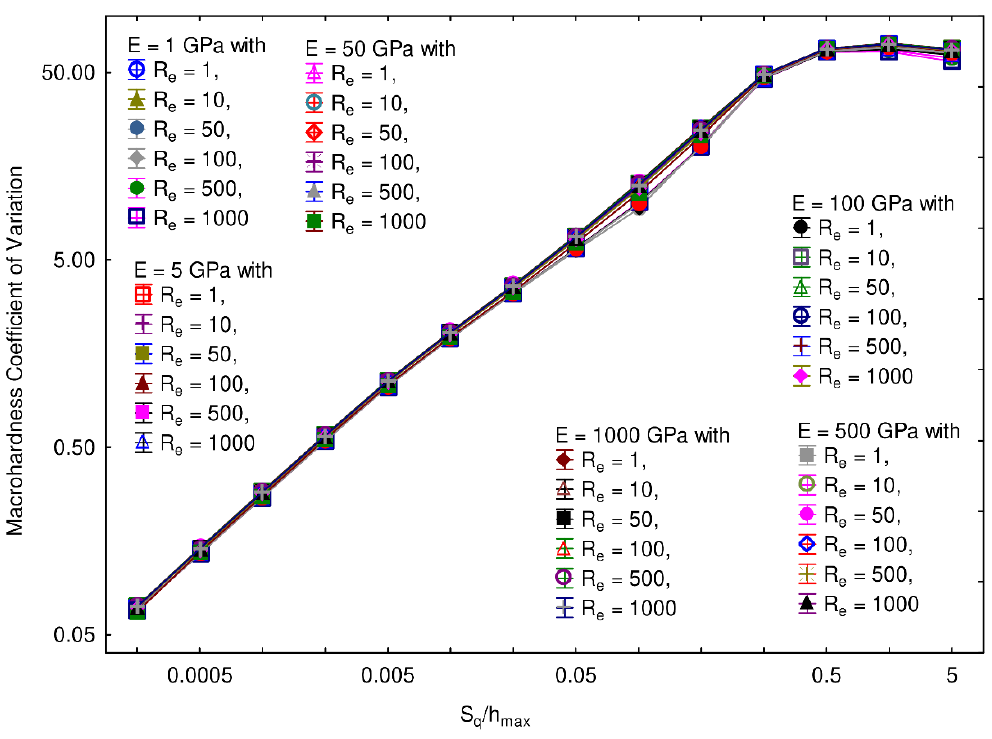
Figure 9. Coefficient of variation of the macrohardness as a function of the ratio S q /h max for different values of Young’s modulus E and elastic limit R e . The mesh size, wavelength, and fractal dimension were, respectively, set to 256 × 256, 32 µm, and 2.5.